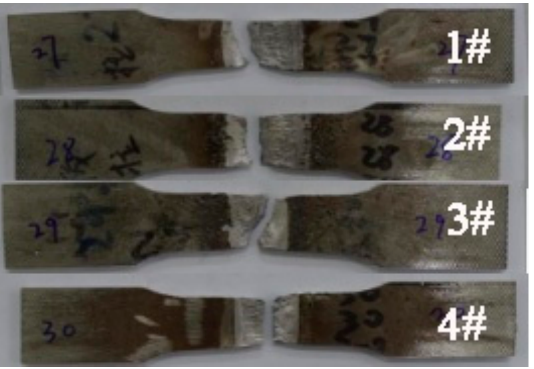
Figure 9. Fracture locations of flat tensile specimens with different treatments methods: 1—untreated; 2—pneumatic chipping hammer; 3—ultrasonic peeing treatment; 4—heat treatment.